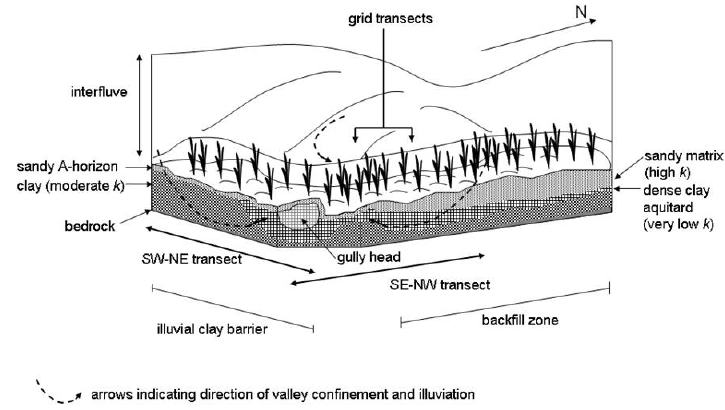
Fig. 17. Schematic of conceptual model for clay-plug development in the Manalana wetland (not to scale).